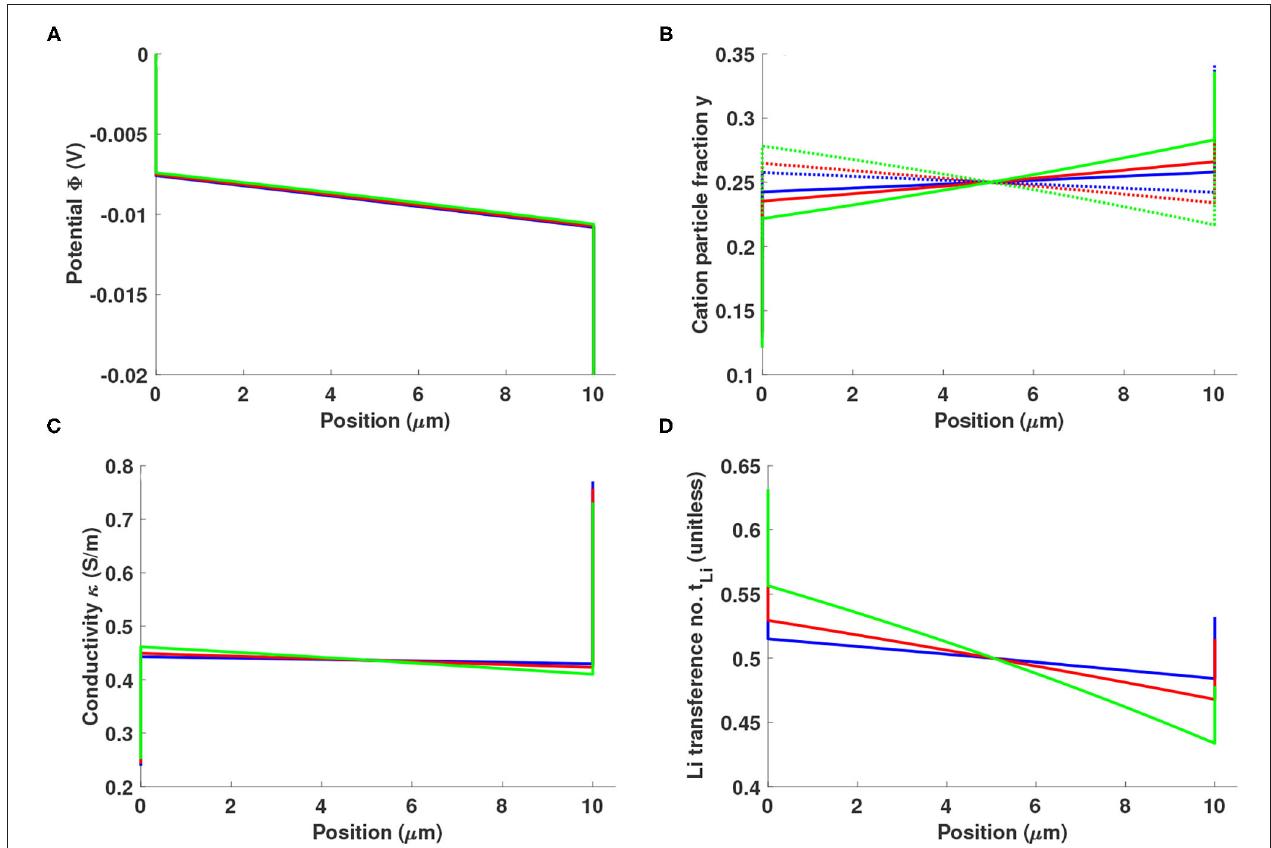
FIGURE 3 | Distributions of (A) potential 8 , (B) cation particle fraction (solid line: y + , dotted line: y Li ), (C) local ionic conductivity κ , and (D) local lithium transference number in a 10 µ m-thick layer of Li 0.5 bmim 0.5 BF 4 sandwiched between two reactive electrodes with f int = 1 kHz, under a potential bias of 20 mV. The Stefan-Maxwell diffusivity of Li + through bmim + , D Li + , is varied across values of D +− / D Li + = − 0.5 (blue), 0 (red), and 1